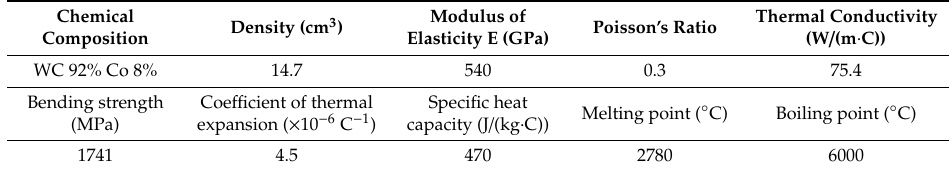
Table 2. Physical properties of YG8 hard metal.